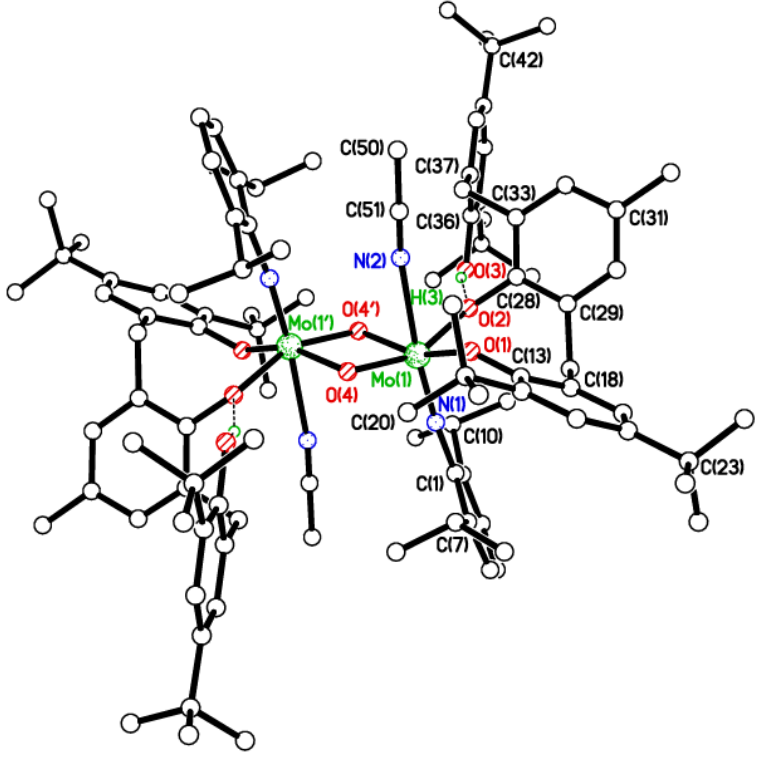
Figure 4. Molecular structure of [Mo(NC 6 H 3 i -Pr 2 -2,6)(NCMe)( μ -O)L 2 H] 2 ( 4 ), showing the atom numbering scheme. Six MeCN molecules of crystallization and most H atoms omitted for clarity. Selected bond lengths (Å) and angles (°): Mo(1)–O(1) 1.9072(16), Mo(1)–O(2) 2.0257(16), Mo(1)–O(4) 1.8688(16), Mo(1)–N(1) 1.728(2), Mo(1)–N(2) 2.400(2); O(1)–Mo(1)–O(2) 93.43(7), Mo(1)–O(1)–C(13)